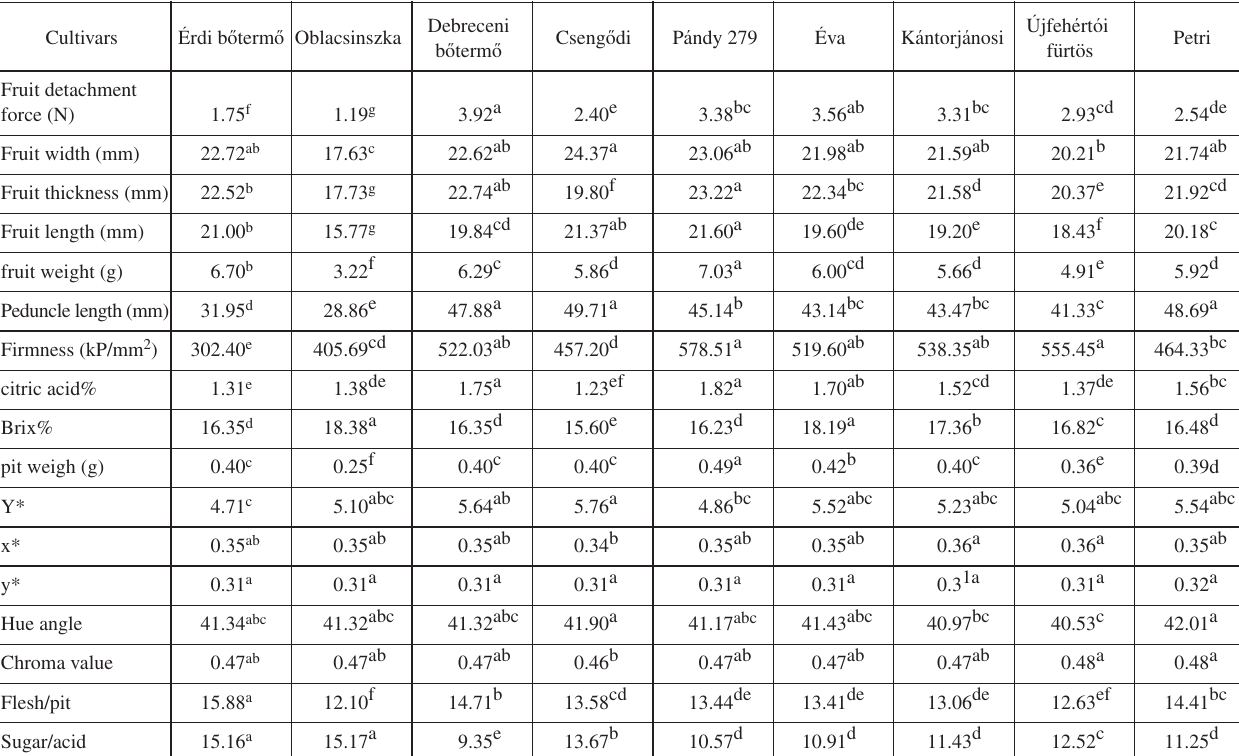
Table 2. Mean values of assessed characteristics and their span in nine sour cherries cultivars